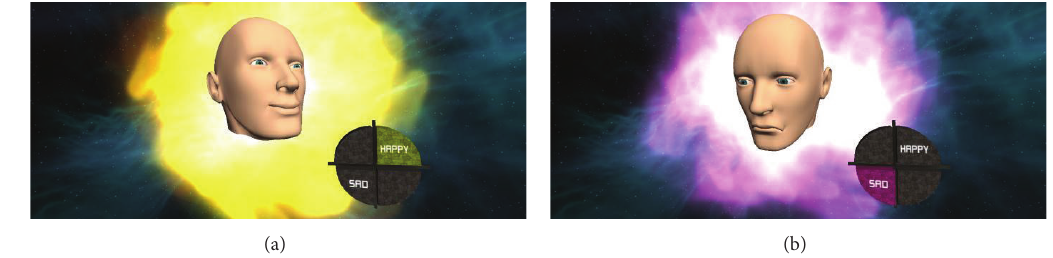
Figure 12: Screenshot of AVATAR game: (a) happy and (b)